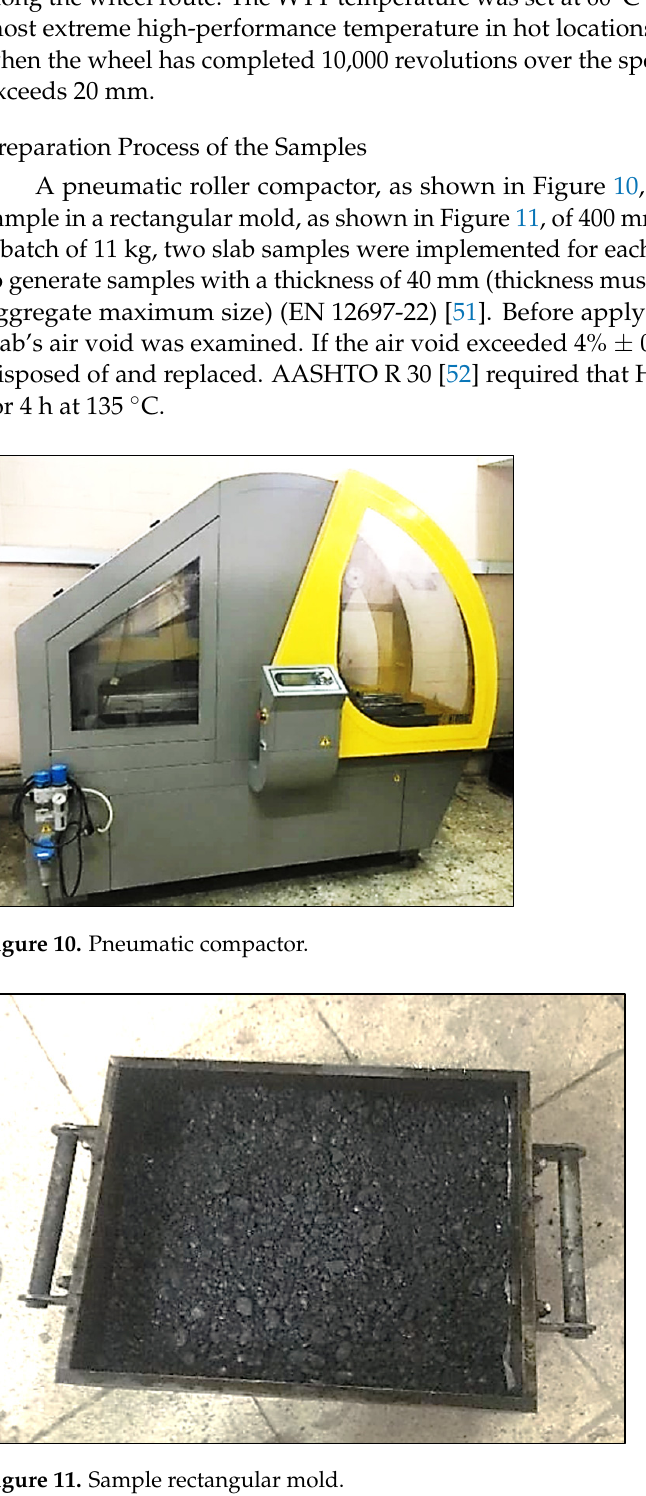
Figure 11. Sample rectangular mold.